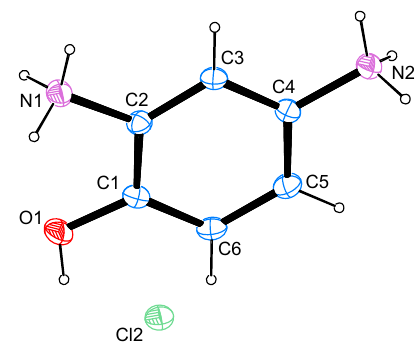
Table  : Data collection and handling.